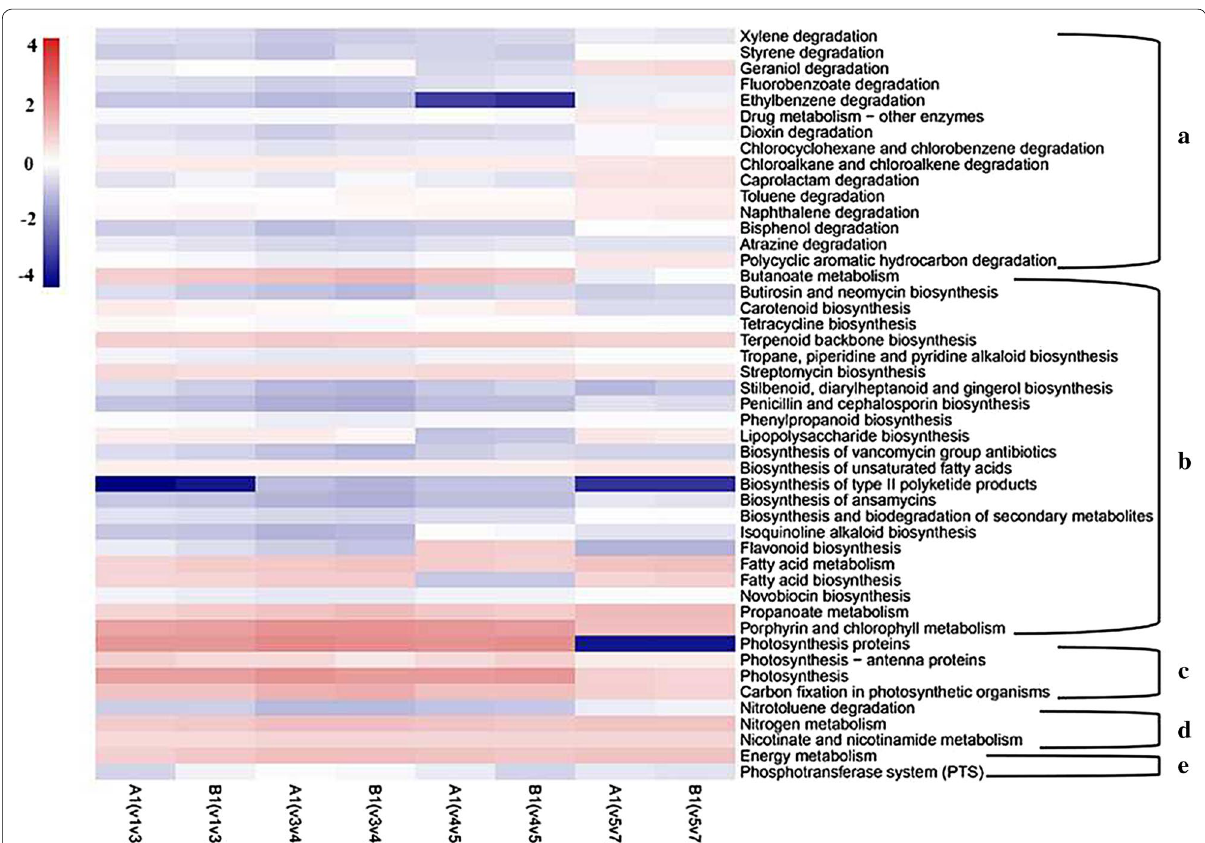
Fig. 4 Heatmap of predicted functional pathways assigned to interesting genes investigated in bacteria of AFTs. Functional genes are related to degradation of harmful compounds ( a ), biosynthesis of valuable metabolites ( b ), photosynthesis ( c ), nitrogen metabolism ( d ), and energy metabolism ( e